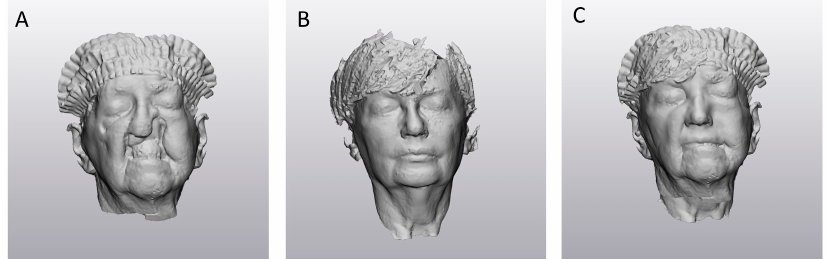
Figure 3. STL files of the facial scan of the patient ( A ), of the patient’s daughter ( B ), and the result of the Boolean union of the two scans ( C ).